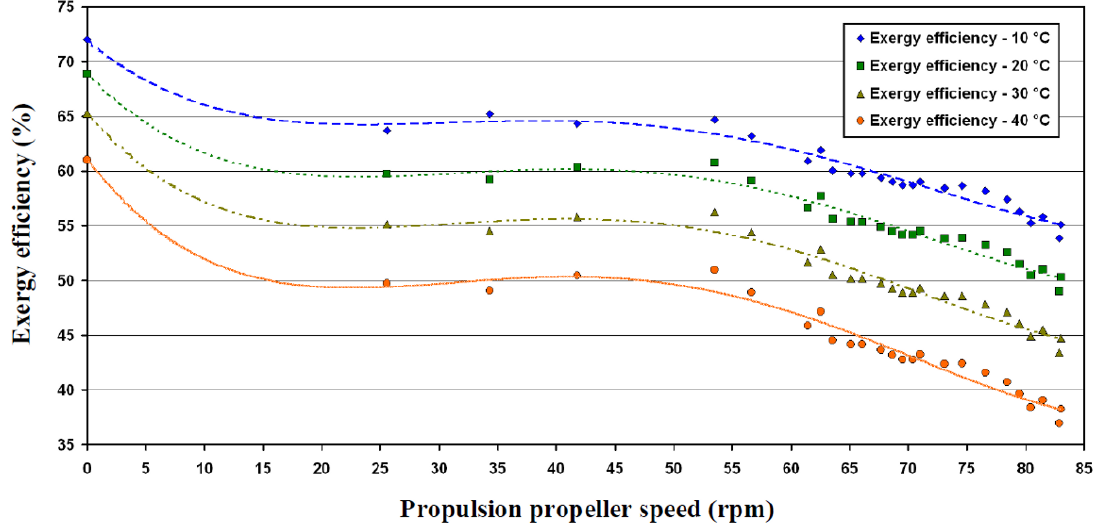
Figure 10. Steam air heater exergy efficiency for various ambient temperatures.